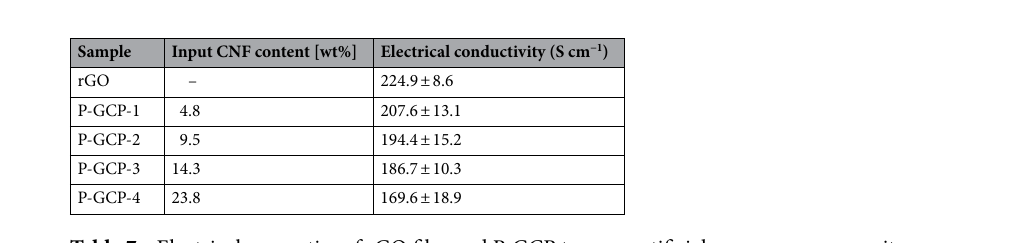
Table 7. Electrical properties of rGO film and P-GCP ternary artificial nacre nanocomposites.